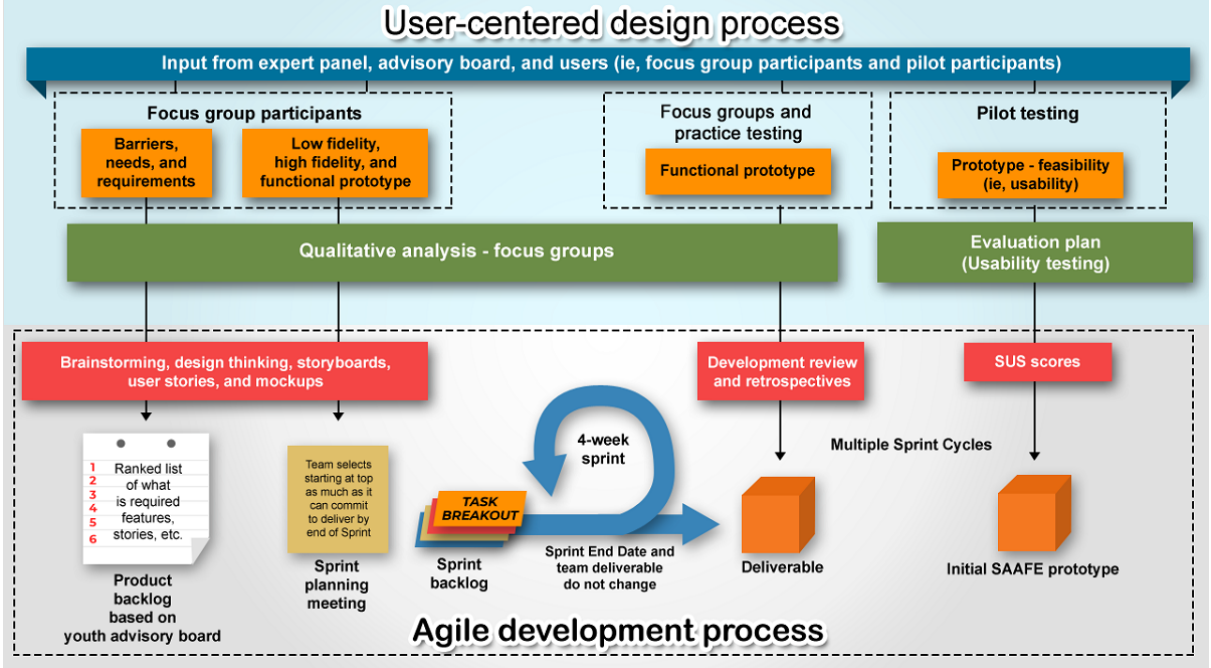
Figure 1. User-centered design processes. SAAFE: Sexually Active Adolescent–Focused Education; SUS: System Usability